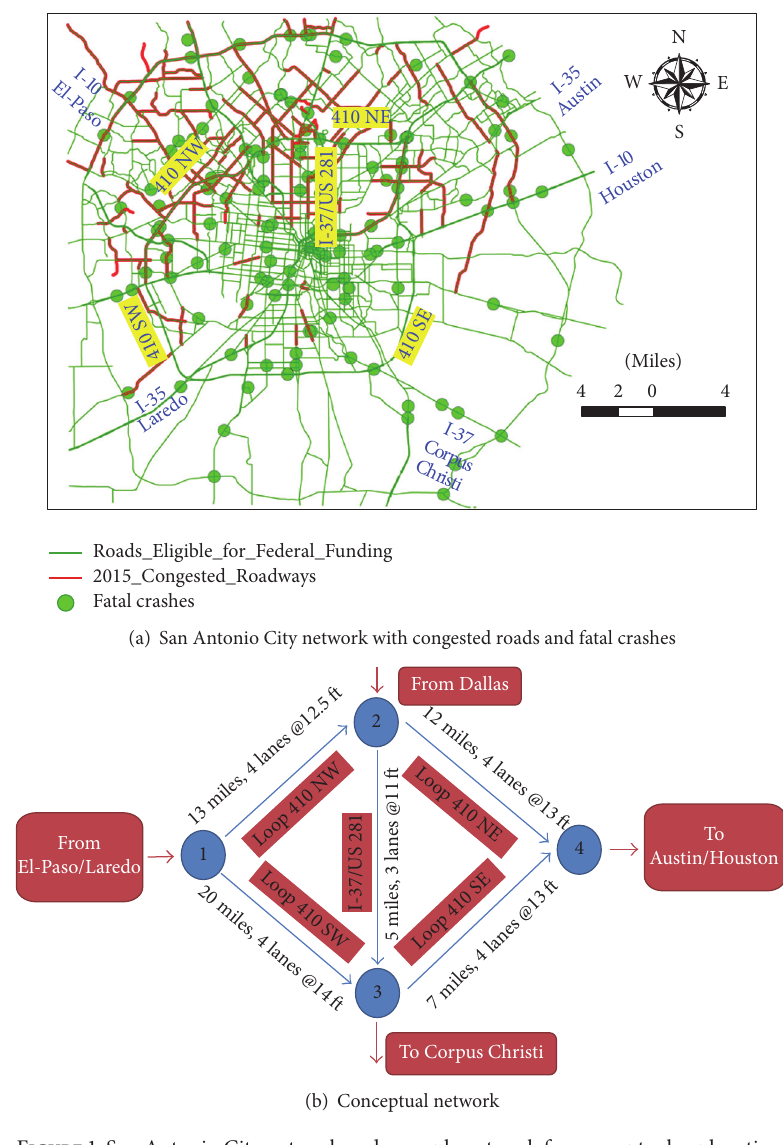
Figure 1: San Antonio City network and example network for conceptual